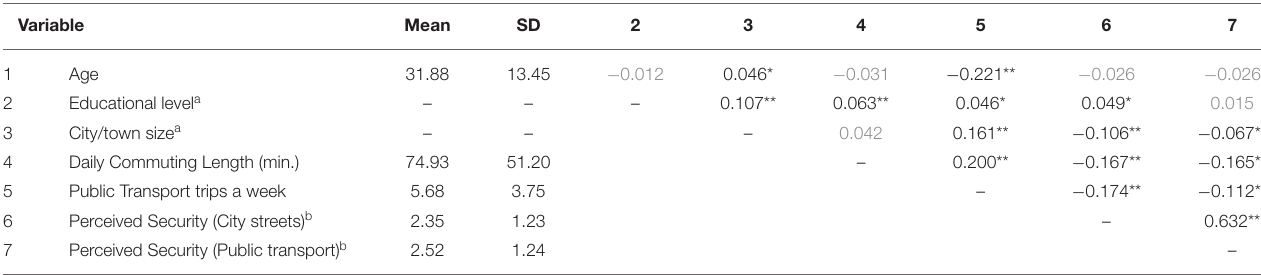
TABLE 3 | Descriptive statistics and bivariate (Spearman’s r s ) correlations between study variables. Variable